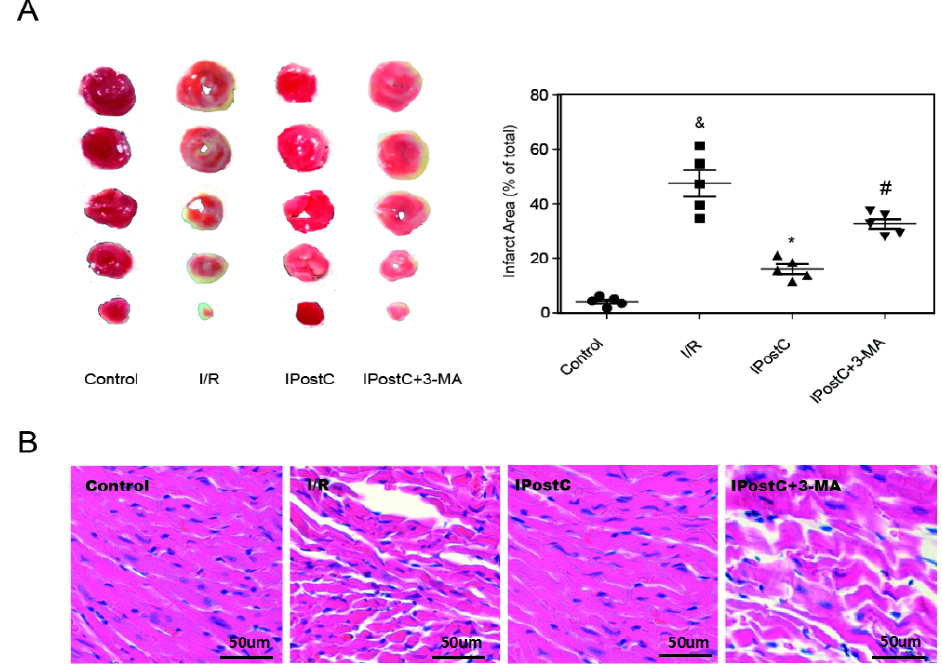
Figure 5. The protective effect of IPostC in the myocardium was inhibited by an autophagy inhibitor. ( A ) Infarct size was measured at 120 min of reperfusion; ( B ) Representative histological images of hearts at 120 min of reperfusion. & p < 0.05 versus control, * p < 0.05 versus I/R, # p < 0.05 versus IPostC. The mean values ± SEM, n = 6.